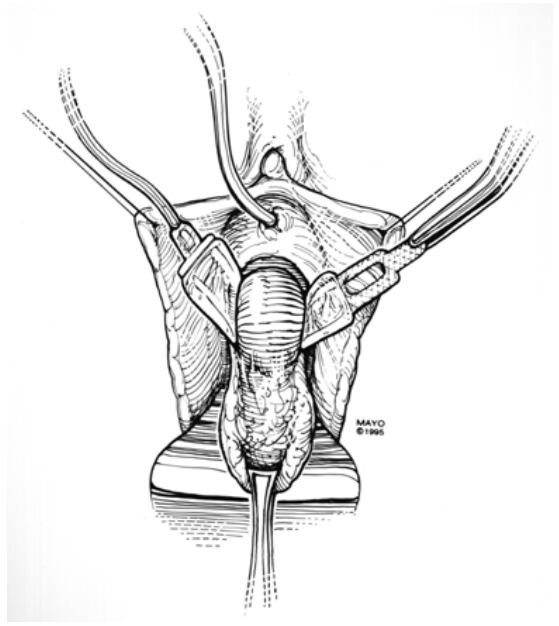
FIGURE 13. Cuff as it is passed behind the bladder neck